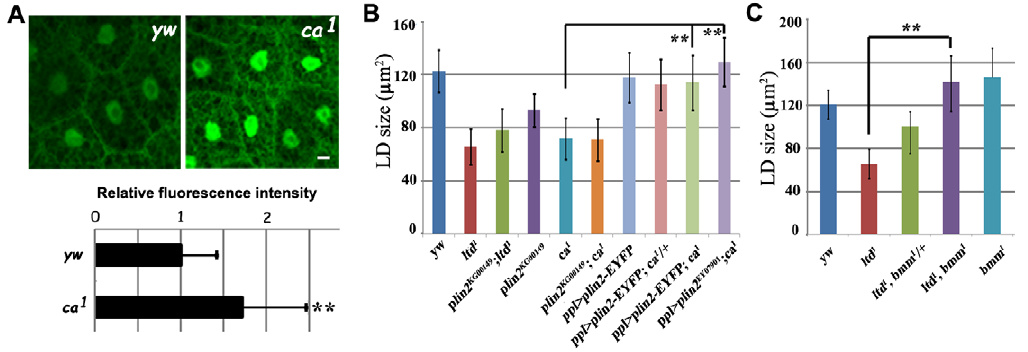
Figure 4. ltd and ca genetically interact with the two lipolysis-related genes bmm and plin2 . (A) Image and fluorescence intensity quantification of lipogenic reporter Gal4-SREBP . UAS-GFP in ca mutants and control. Scale bar: 20 m m. **: P , 0.001. (B) Quantification of lipid droplet size in different genetic backgrounds. ltd ; plin2 or ca ; plin2 double mutants did not show an enhanced phenotype compared to single mutants. Overexpressing plin2 suppresses ca . The error bars represent the standard deviation. **: P , 0.001. (C) Quantification of lipid droplet size in different genetic backgrounds. bmm mutants suppress ltd mutants in a dosage-dependent manner. The error bars represent the standard deviation. **: P , 0.001.